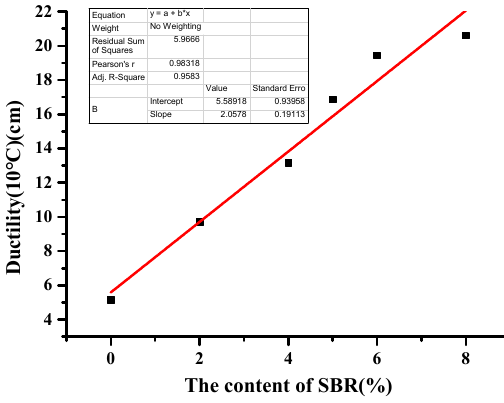
Figure 6. Fitting curves of SBR content and penetration.